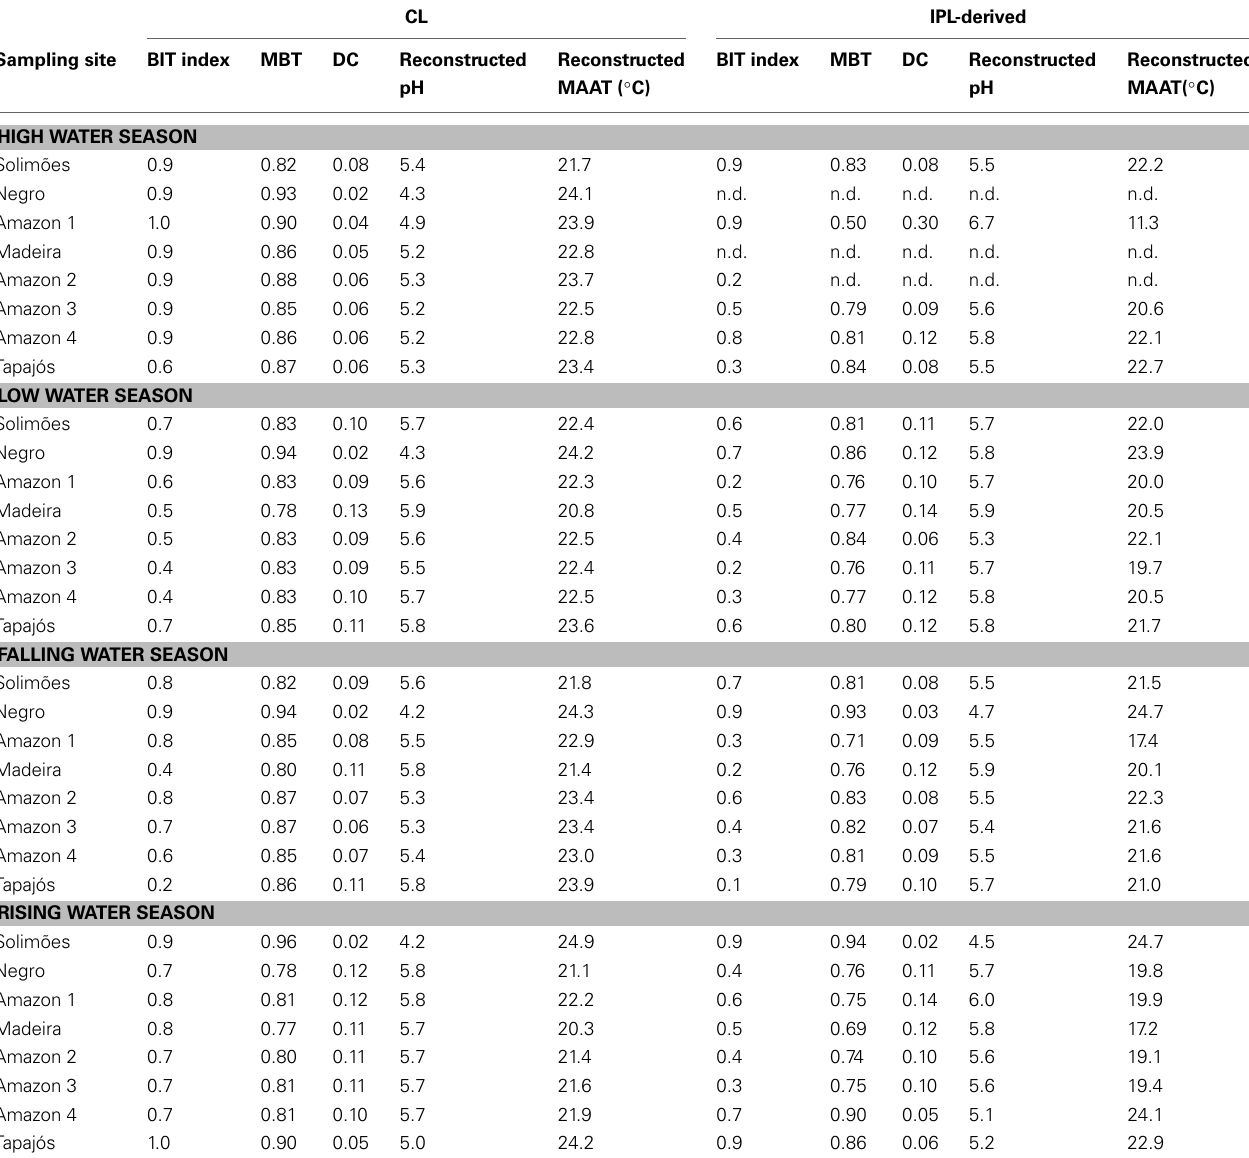
Table 3 | BIT, MBT, DC, reconstructed pH and reconstructed MAAT values of all analyzed